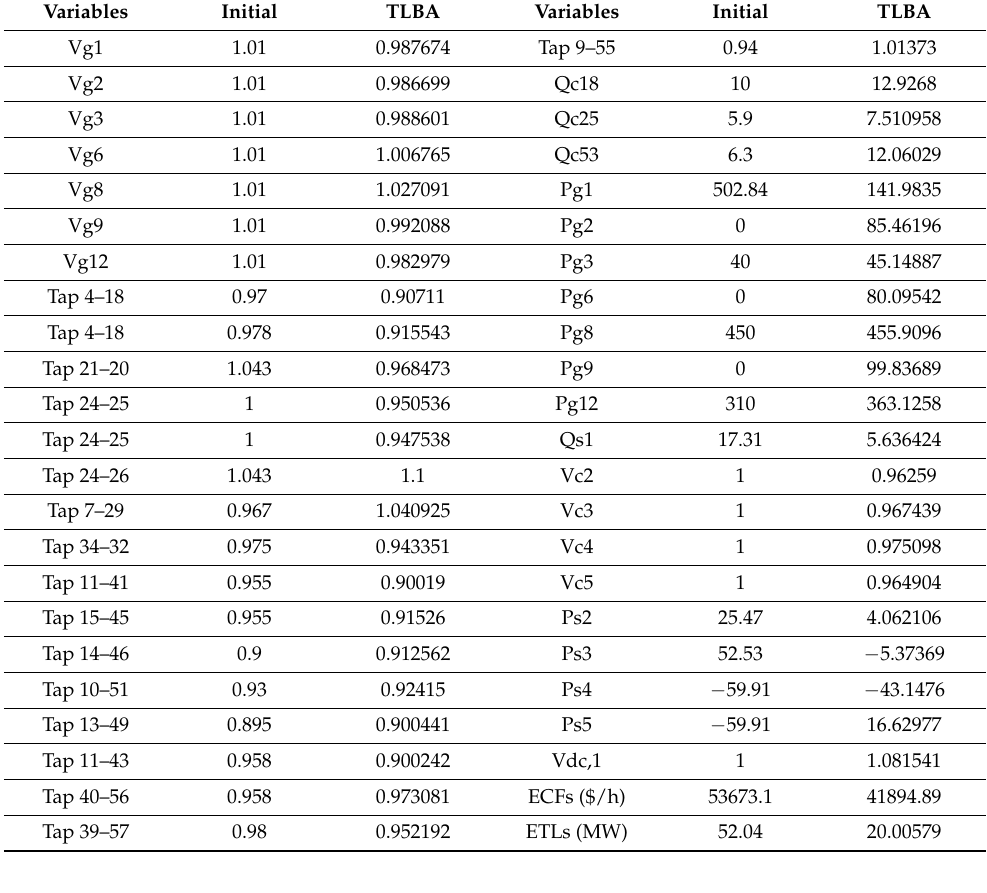
Table 7. Simulation results of TLBA for the minimization of the TFCs of the IEEE 57-bus network.